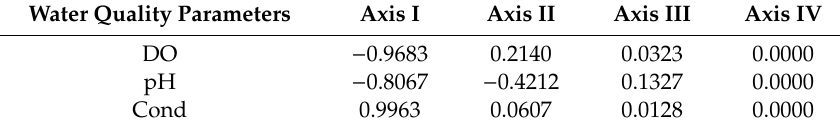
Table 5. Correlation of water quality parameters with the axes.